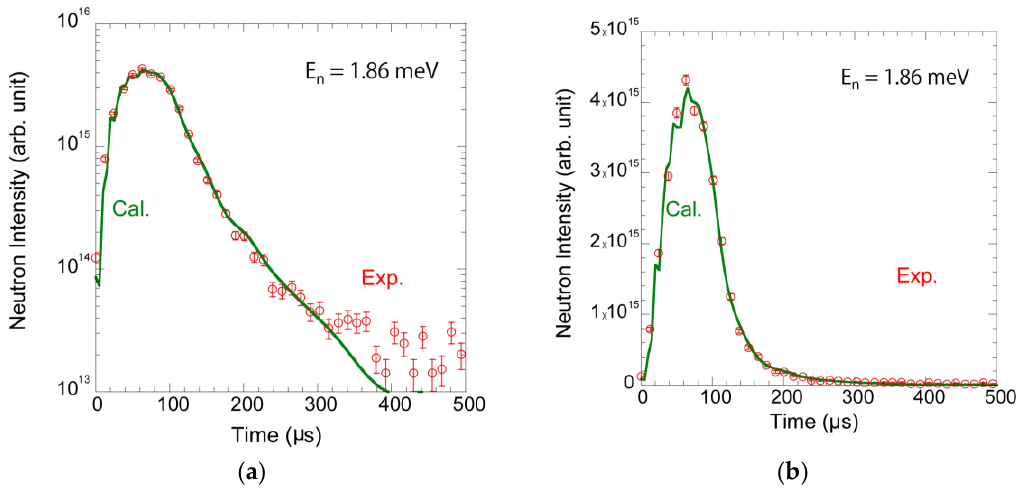
Figure 13. Measured and calculated neutron pulse emitted with 1.86 meV from decoupled moderator [40]. Graph is shown by logarithmic scale ( a ) and linear scale ( b ) in vertical axis. Open circle and solid line represents measured data and calculated results, respectively.